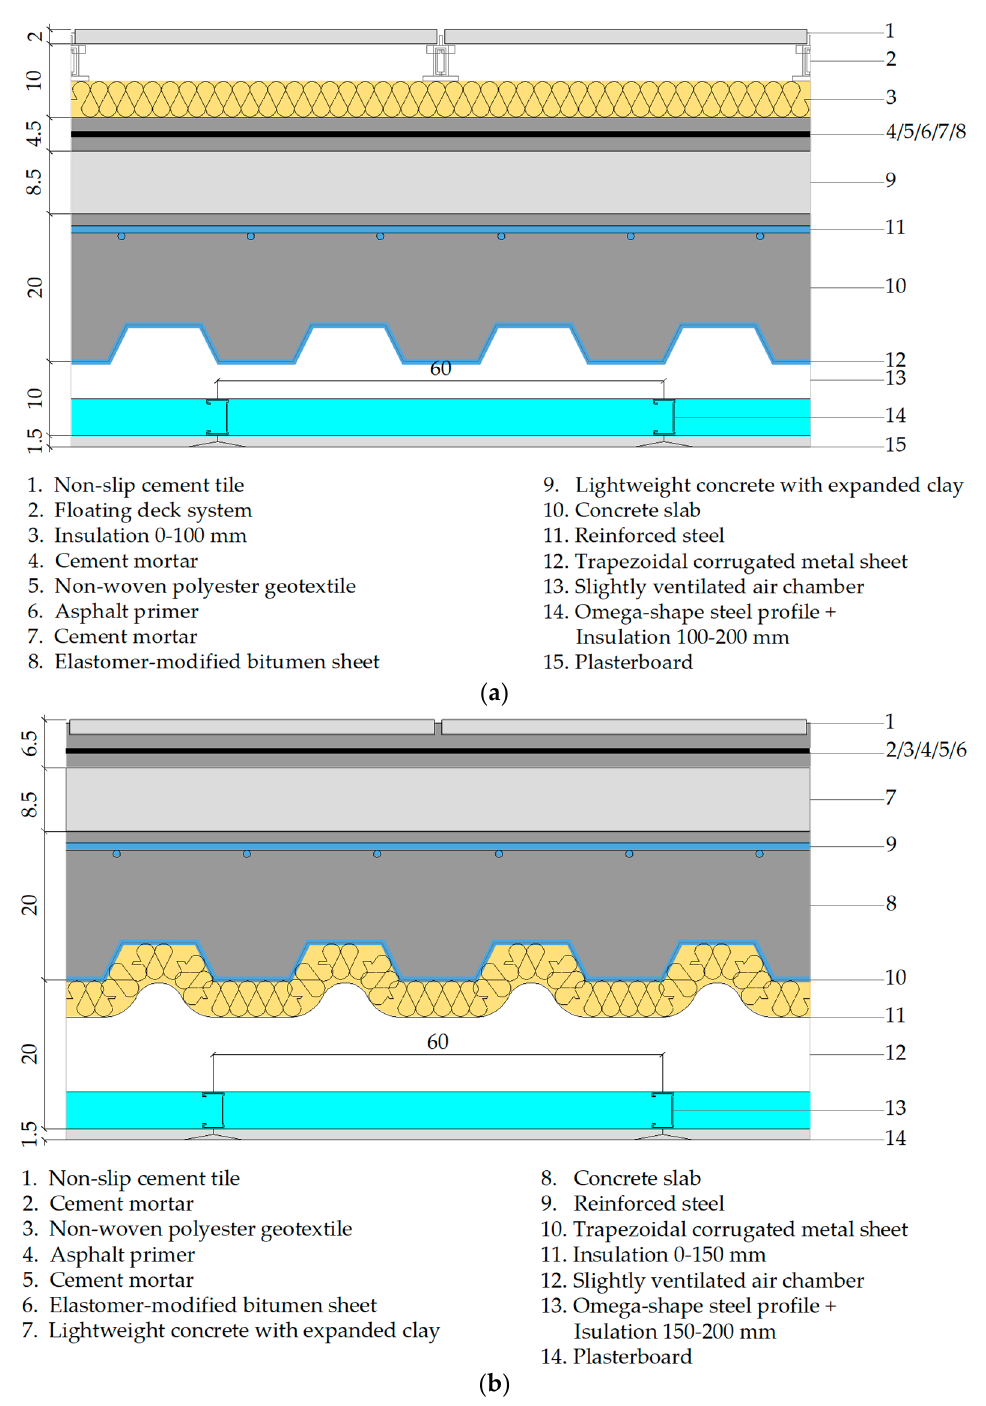
Figure A1. ( a ) Roof floor components detail for constructive solution 1. ( b ) Roof floor components detail for constructive solution 2.